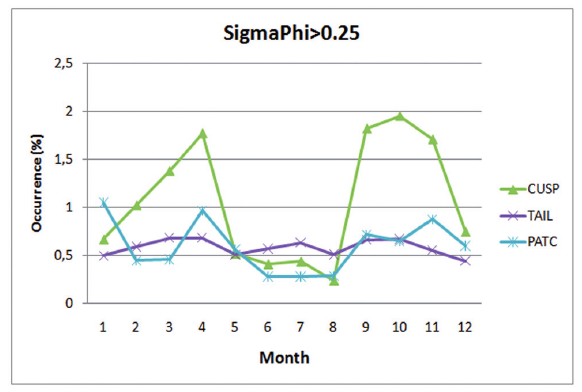
Figure 9. Seasonal variation of the percentage occurrence above the moderate/ strong threshold for v U sorted according to the ionospheric hot spots at high